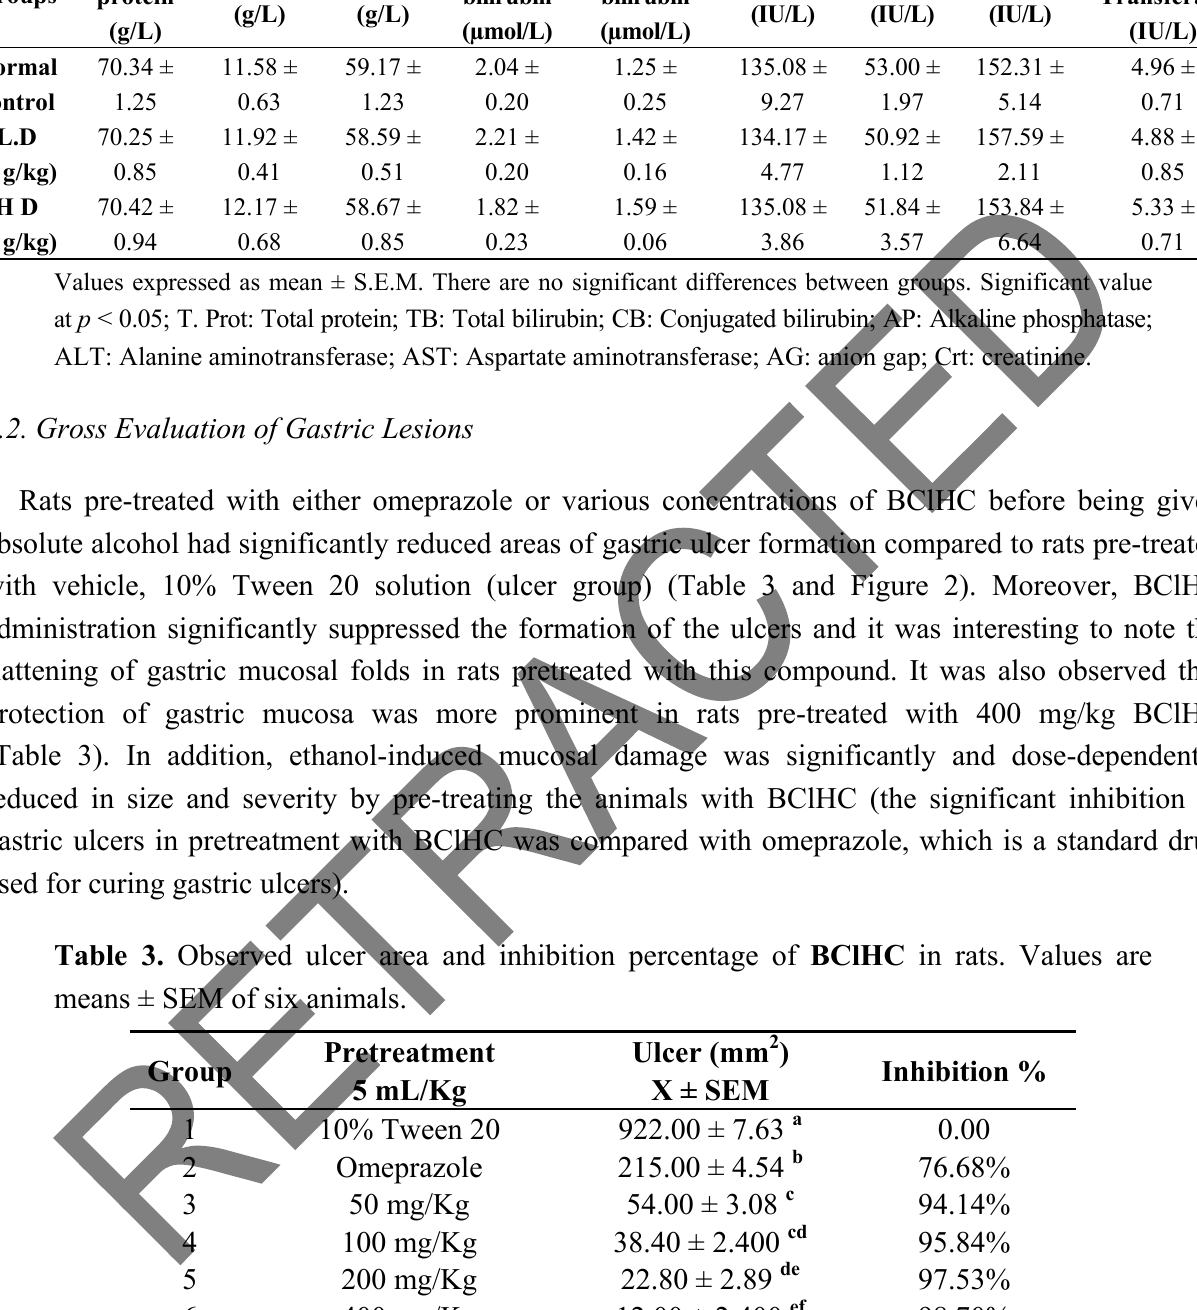
G-Glutaml. Transferase (IU/L)